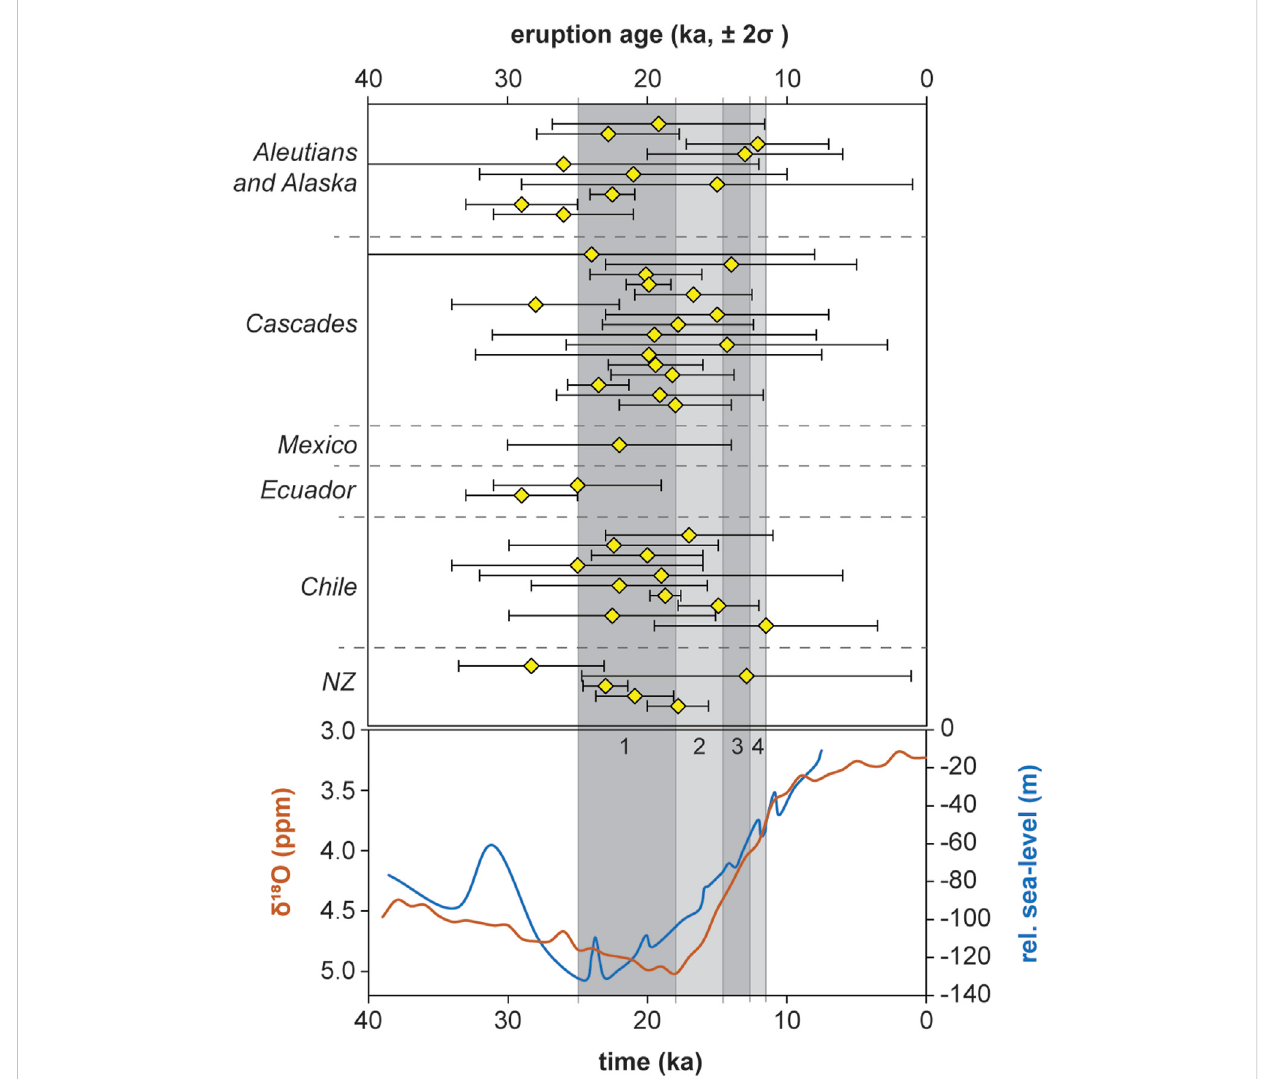
FIGURE 7 Comparison of the precision of radiometric dating constraints for lava eruption ages and the timing of the Last Glacial Termination. 40 Ar/ 39 Ar and K-Ar data for lavas with preferred ages between 30 and 10 ka were compiled from the reviewed papers (see Table 2). Error bars are 2 σ . The stacked benthic δ 18 O curve of Lisiecki and Raymo (2005) is plotted in orange, and the reconstructed relative sea-level of Thompson and Goldstein (2006) is plotted in blue in the lower panel. Periods within the Last Termination are labelled with numbers: (1) Last Glacial Maximum; (2) Heinrich Stadial 1; (3) Antarctic Cold Reversal; (4) Younger